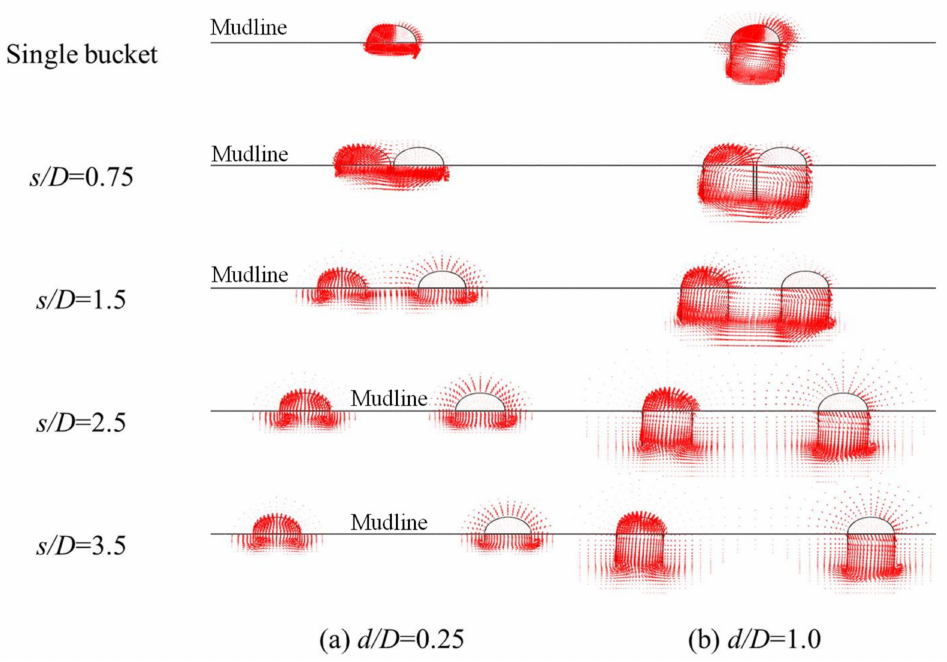
Figure 16. The vector fields of the displacement of the single bucket foundation and tetrapod bucket foundations under ultimate moment loading at κ = 10 when ( a ) d/D = 0.25 and ( b ) d/D = 1.0. The moment capacity of tetrapod bucket foundations in the push–pull failure mode ( M max,pp ) can be calculated by the vertical tensile and compressive resistances of individual buckets ( V ult,s ) as shown in Figure 17 and Equations (9) and